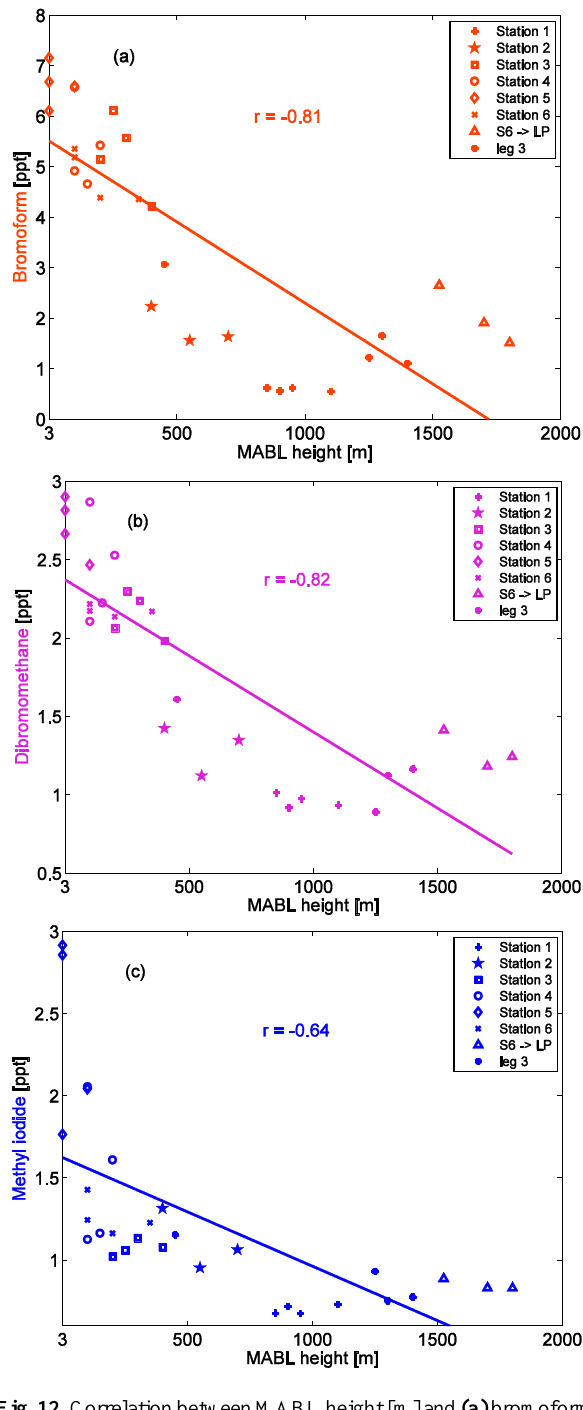
Fig. 12: Correlation between MABL height [m] and a) bromoform, b) dibromomethane and c) 726 Fig. 12. Correlation between MABL height [m] and (a) bromoform, methyl iodide abundances [ppt] for the whole cruise. The different marker reflect the different 727 (b) dibromomethane and (c) methyl iodide abundances [ppt] for the whole cruise. The different markers reflect the different locations: locations, leg 2 including stations 1 – 6, the transit between station 6 and Las Palmas, and leg 728 leg 2 including stations 1–6, the transit between station 6 and Las 3. transit between station 6 and Las Palmas, and leg 3. The according p-values are less than 729 Palmas, and leg 3. The according p values are less than 1% for all three correlations, with each including 30 1 % for all three correlations with each including 30 samples. 730